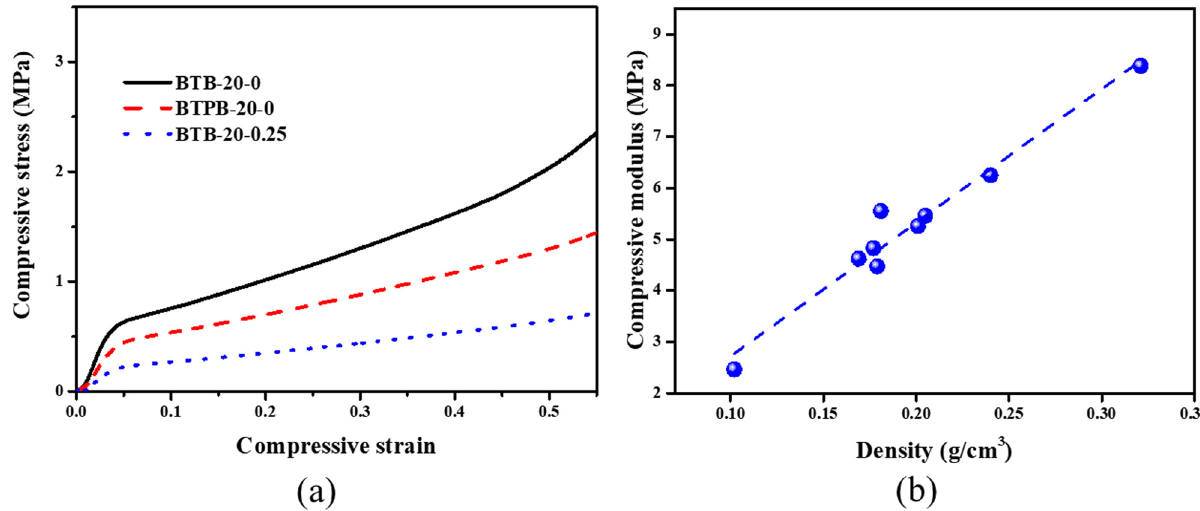
Figure 6: ( a ) Stress – strain curves for selected BPSQ aerogels. ( b ) Modulus versus density plot for various BTPB ( /TMOS ) aerogels.